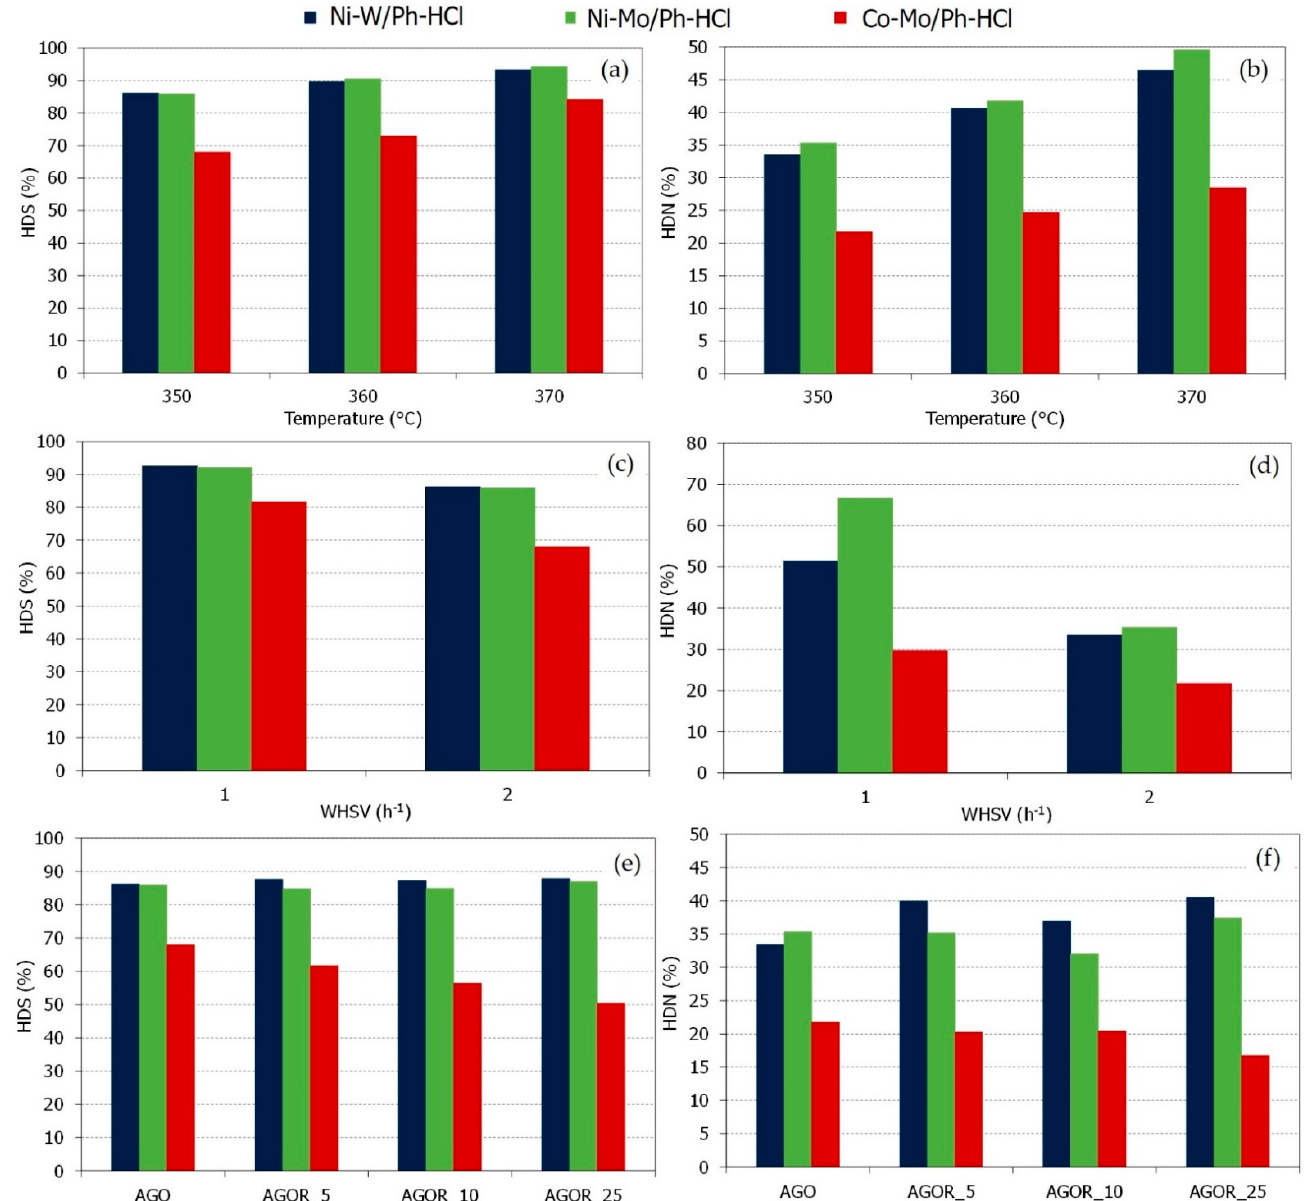
Figure 6. HDS and HDN efficiencies of Ph-HCl-supported catalysts (Ni-W/Ph-HCl, Ni-Mo/Ph-HCl and Co-Mo/Ph-HCl) for AGO processing at different temperatures (( a , b ): 350–370 °C, WHSV 2 h − 1 , 5.5 MPa), WHSV (( c , d ): 350°C, WHSV 1–2 h − 1 , 5.5 MPa) and co-processing (( e , f ): 95/5, 90/10 and 5.5 MPa), WHSV (( c , d ): 350 ◦ C, WHSV 1–2 h − 1 , 5.5 MPa) and co-processing (( e , f ): 95/5, 90/10 and 75/25; 350 °C, WHSV 2 h − 1 , 5.5 MPa). 75/25; 350 ◦ C, WHSV 2 h − 1 , 5.5